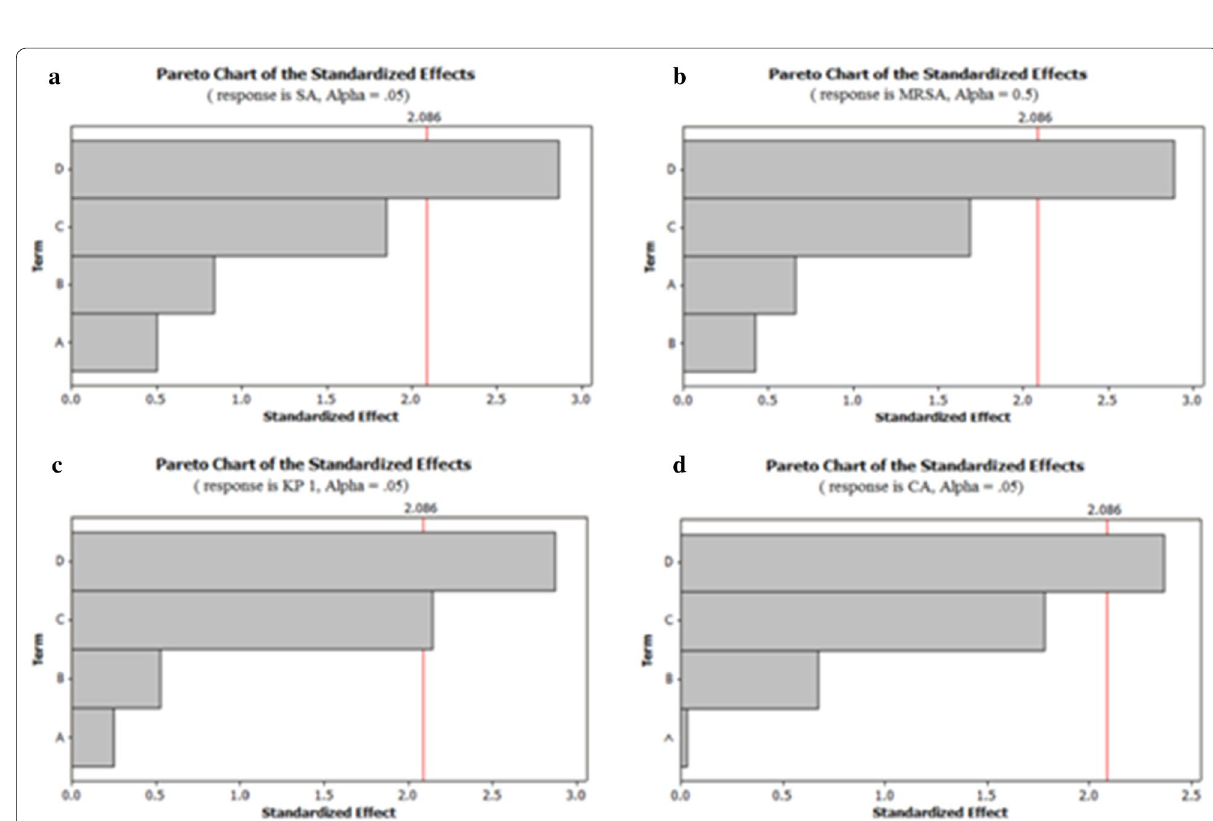
Fig. 7 Pareto charts of a S. aureus , b MRSA, c K. pneumoniae 1, d C. albicans. *D-Starch, C-Maltose, B-Peptone, A-Ammonium